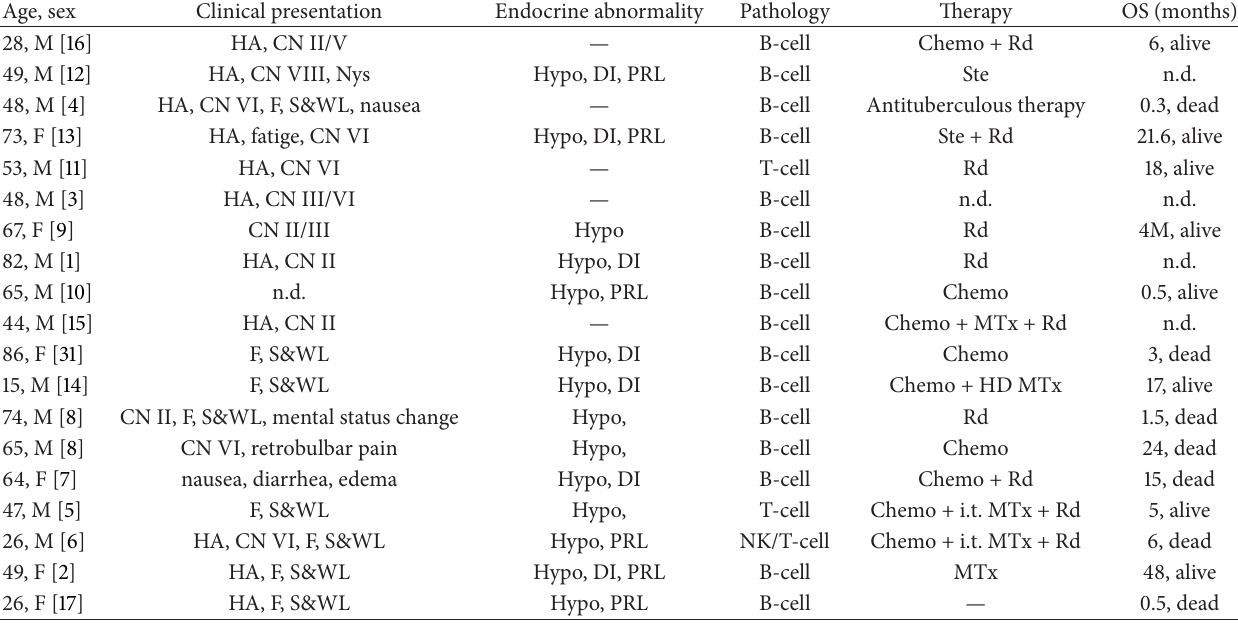
Table 1: Clinical summary of 19 patients with PPL.